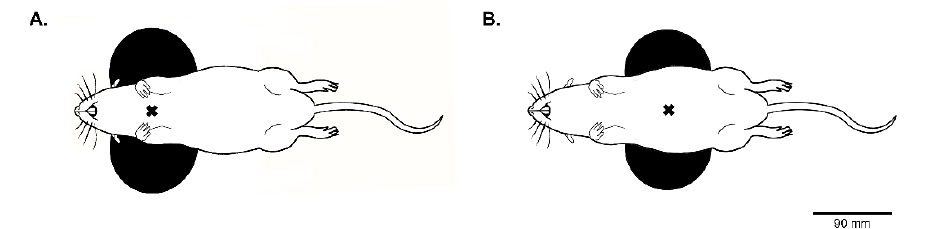
Figure 1. Representative image of a rat positioned on the magnetic coil: ( A ) Position of rat on the figure-of-eight coil, during gastrocnemius and brachioradialis MEP recordings, under isoflurane and urethane anesthesia. ( B ) Position of the rat on the figure-of-eight coil during gastrocnemius MEP recordings for paired-pulse stimulations and for evaluation of TN function before and after crush. The black cross indicates coil’s hot spot according to the manufacturer.